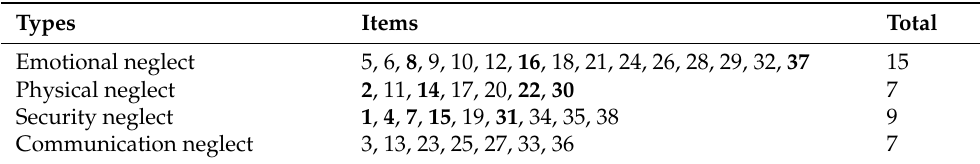
Table 2. Introduction of reverse scoring questions in the